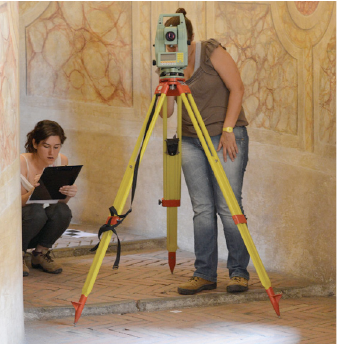
Figure 5. Total station Leica, TCR